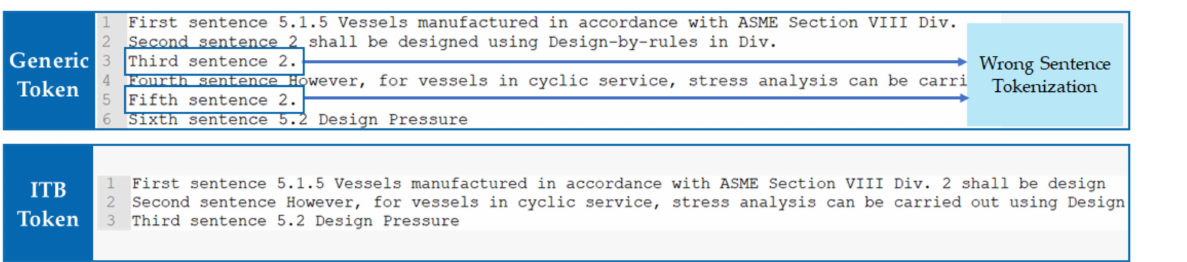
Figure 5. Sentence Tokenizer sentence result example for automatic analysis of technical